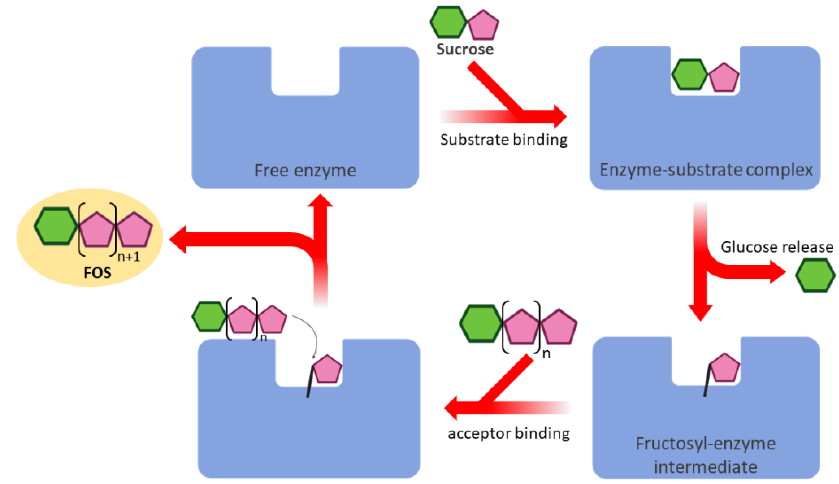
Figure 1. Schematic illustration of the reactions occurring in the active site of fructosyltransferase. Levansucrase was found in many bacteria species, such as Bacillus subtilis (Bs_SacB) [8], Bacillus megaterium (Bm_SacB) [9], Bacillus licheniformis (Bl_SacB) [10] and Lactobacillus reuteri [11]. Both